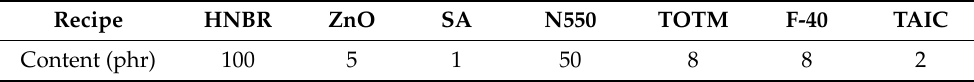
Table 5. Formulation of the HXNBR